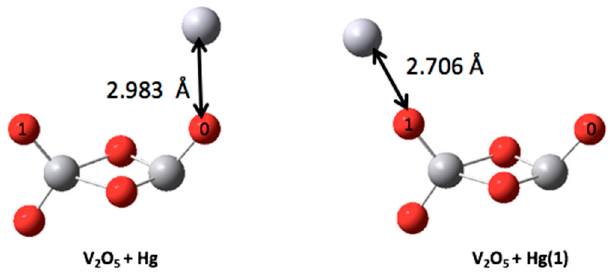
Figure 6. V 2 O 5 and Hg reaction model.